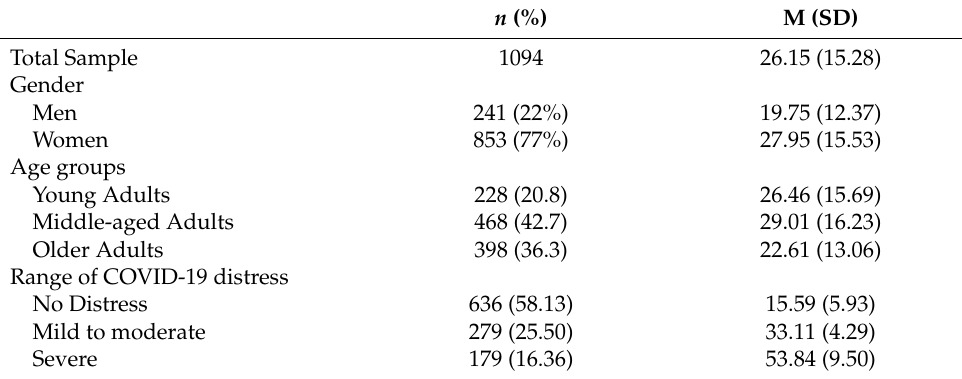
Table 2. Mean values of CPDI scores as a function of gender, age group, and range of COVID-19 distress. SDs are shown in parentheses.